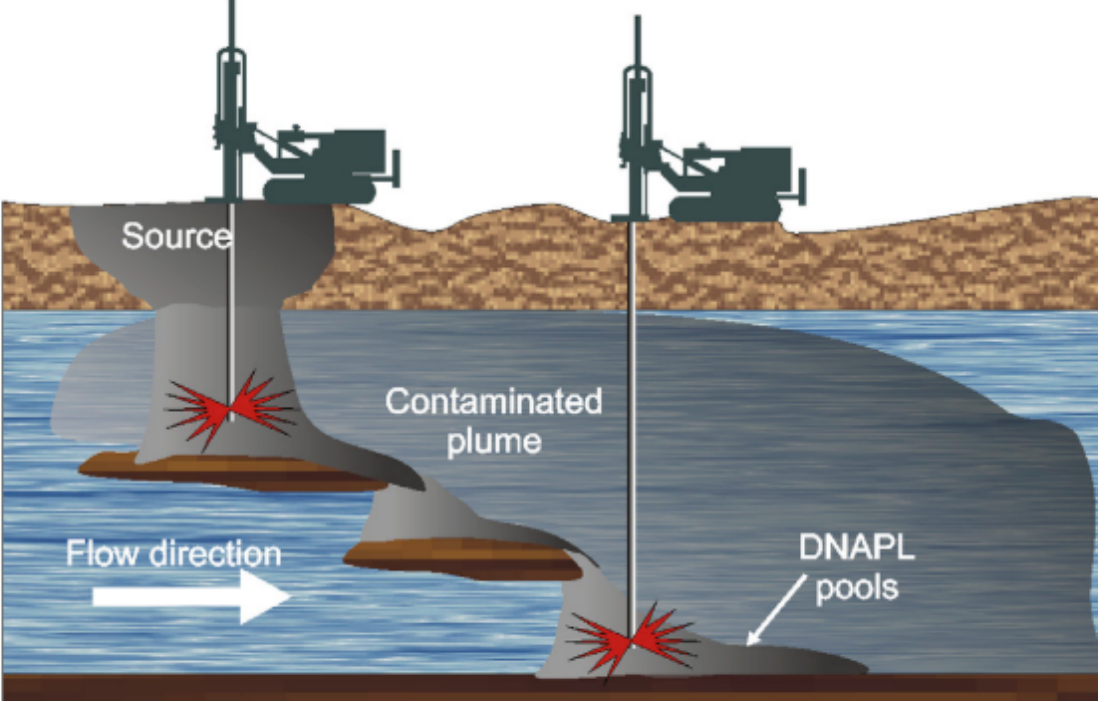
Figure 2. Remediation of an aquifer contaminated by DNAPLs injecting nZVI suspensions directly at the sources of contamination. Reprinted with permission from [83] (2014,